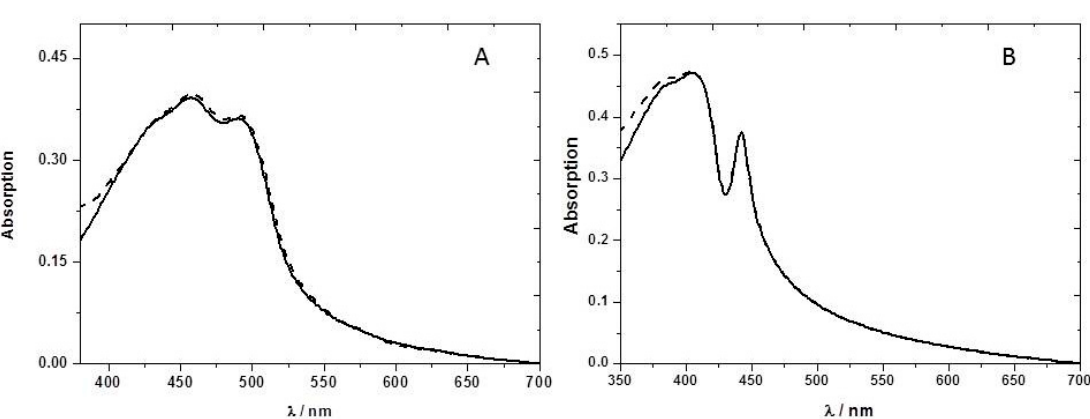
Figure 4. ( A ) Absorption spectra of the F8T2 film in the presence (dashed line) and absence (solid line) of nitrobenzene vapor. ( B ) Absorption spectra of the PFO film in the presence (dashed line) and absence (solid line) of nitrobenzene vapor. Both CPs are incorporated in an ethyl cellulose matrix.